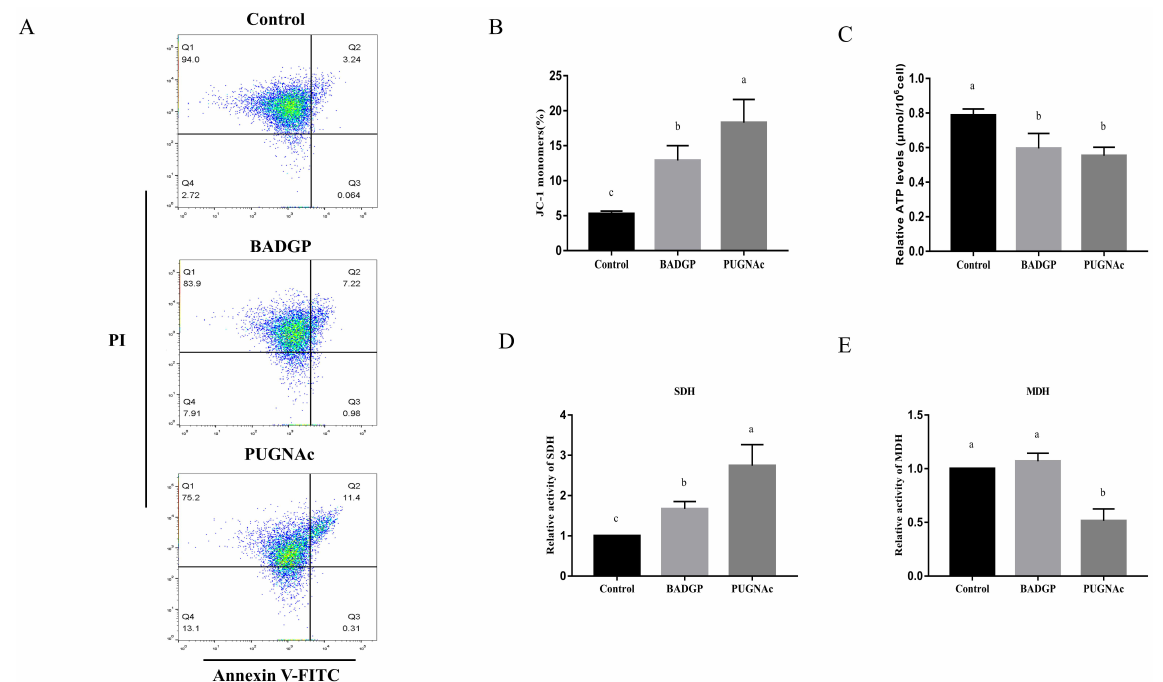
Figure 5. Alteration in O-GlcNAc levels impairs mitochondria homeostasis, ATP production, and the tricarboxylic acid (TCA) cycle. ( A ) Flow cytometric analysis of mitochondrial membrane potential (MMP) in GCs. GCs were stained with JC-1, a reporter molecule for heterogeneity in MMP in living cells. ( B ) Effects of dysregulated O-GlcNAcylation on MMP in GCs. ( C ) Intracellular ATP levels. ( D ) Succinate dehydrogenase (SDH) activity. ( E ) Malate dehydrogenase (MDH) activity. Values are expressed as mean ± SEM of at least three replicates. Different superscript letters (a–c) indicate statistically significant differences ( p < 0.05).